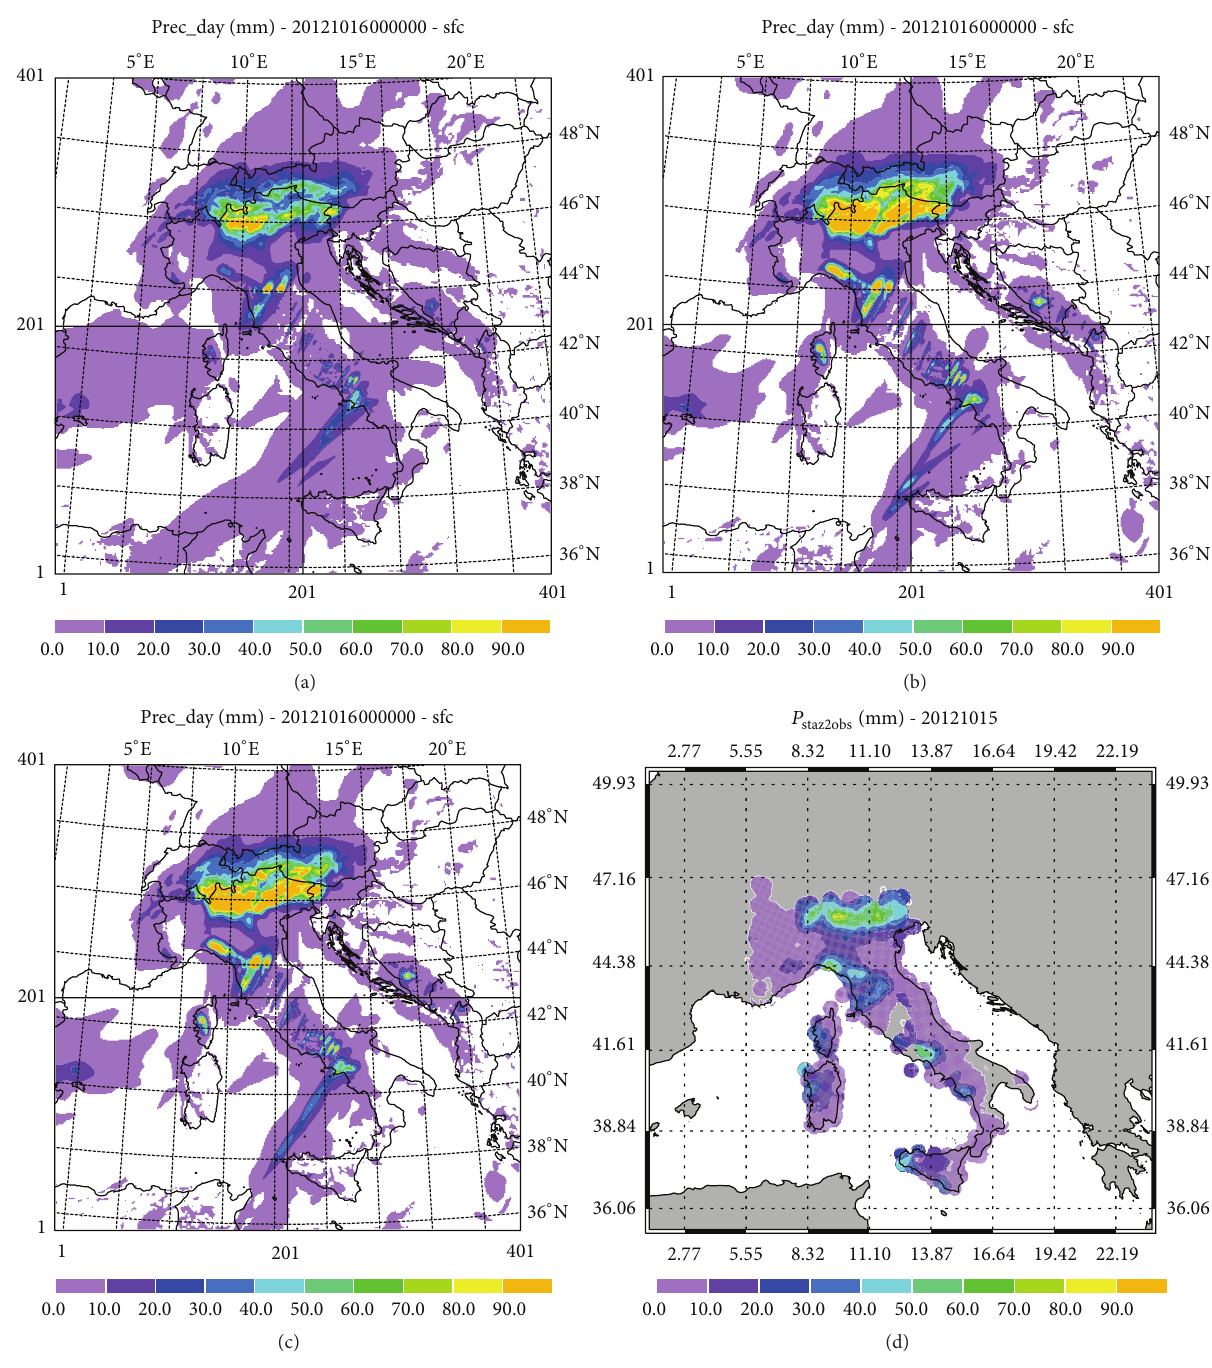
Figure 2: Accumulated rain on October 15, 2012, for (a) R 6; (b) RW5; (c) RW6; (d) objective analysed rainfall for available rain gauges. The objective analysed rainfall is given, at each grid point, by the average of the observations recorded by the rain gauges inside a radius of 30 km from the grid